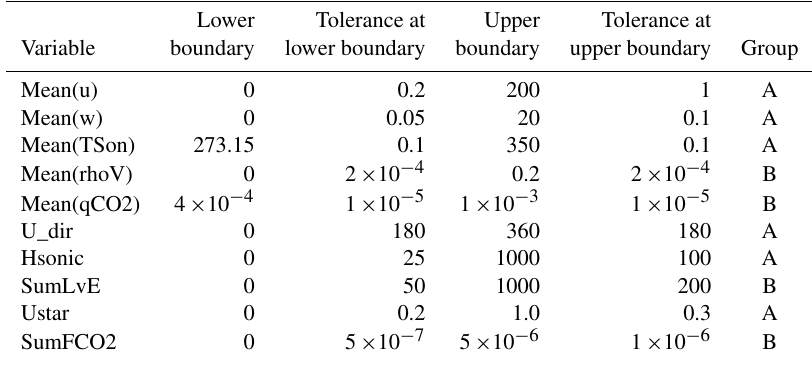
Table 7. Acceptable value ranges of ECpack results and tolerance values at the lower and upper boundary. For the meaning of the “Group” column refer to the